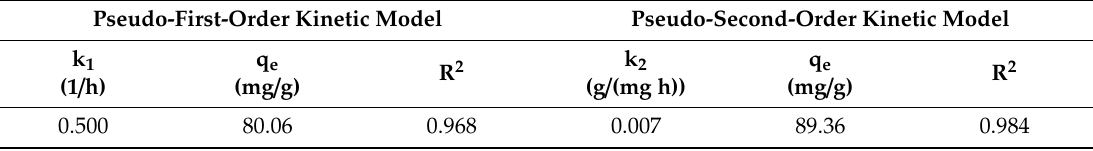
Figure 4. Pseudo-first-order and pseudo-second-order kinetic models (1st and 2nd, respectively) for adsorption of Cu(II) ions onto surface-modified polyacrylonitrile fibers. Here, q and t denote the adsorption capacity and time, respectively. Table 1. Kinetics parameters for adsorption of Cu(II) ions onto surface-modified polyacrylonitrile fibers. Here, k 1 , k 2 , q e , and R 2 denote the pseudo-first- and pseudo-second-order rate constants, amount of Cu(II) removed at equilibrium, and determination coefficient, respectively.